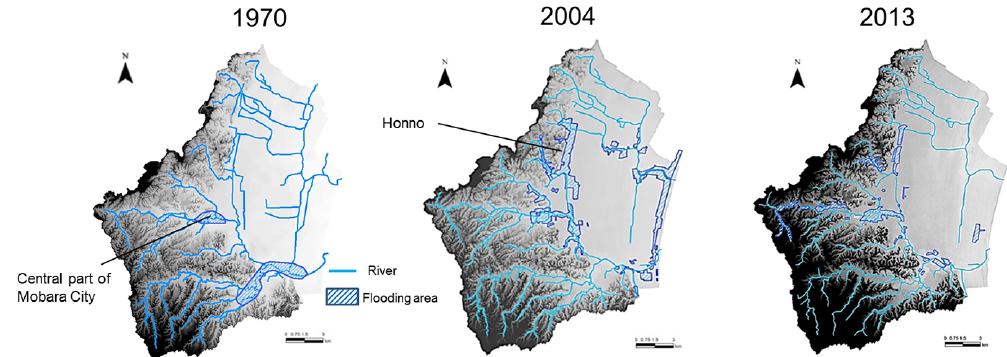
Figure 2. Flood inundation area in 1970, 2004, and 2013. Flood area was digitalized from the flood report of Chiba prefecture (1971, 2005, and